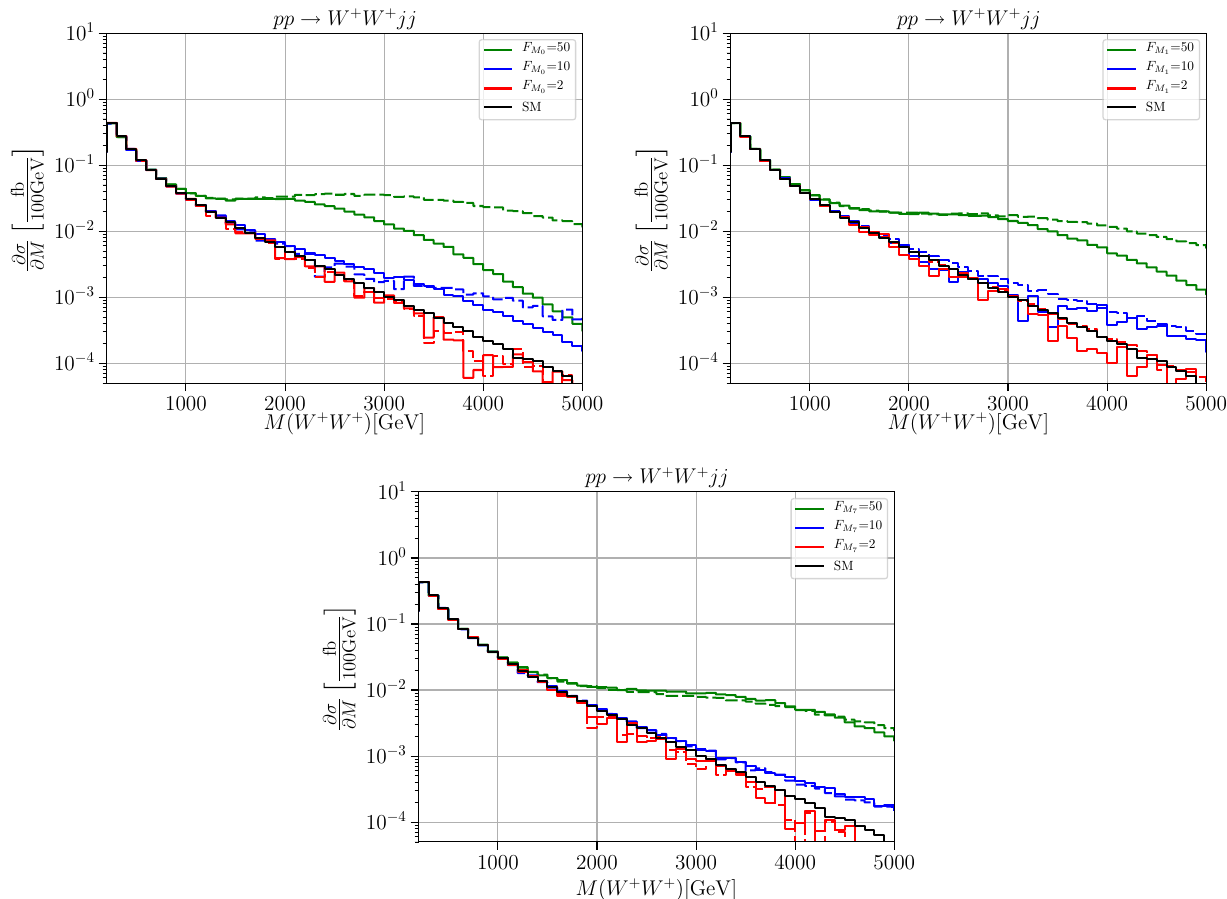
= 2TeV − 4 for i = 0 (upper left panel), i = 1 (upper 10TeV − 4 and F M i right panel), and i = 7 (lower panel), respectively. Solid: unitarized; dashed: naive result. Cuts: M jj > 500 GeV, Δη jj > 2 . 4, | η j | < 4 . 5, = 50 TeV − 4 , F = > 20 p j M i i T